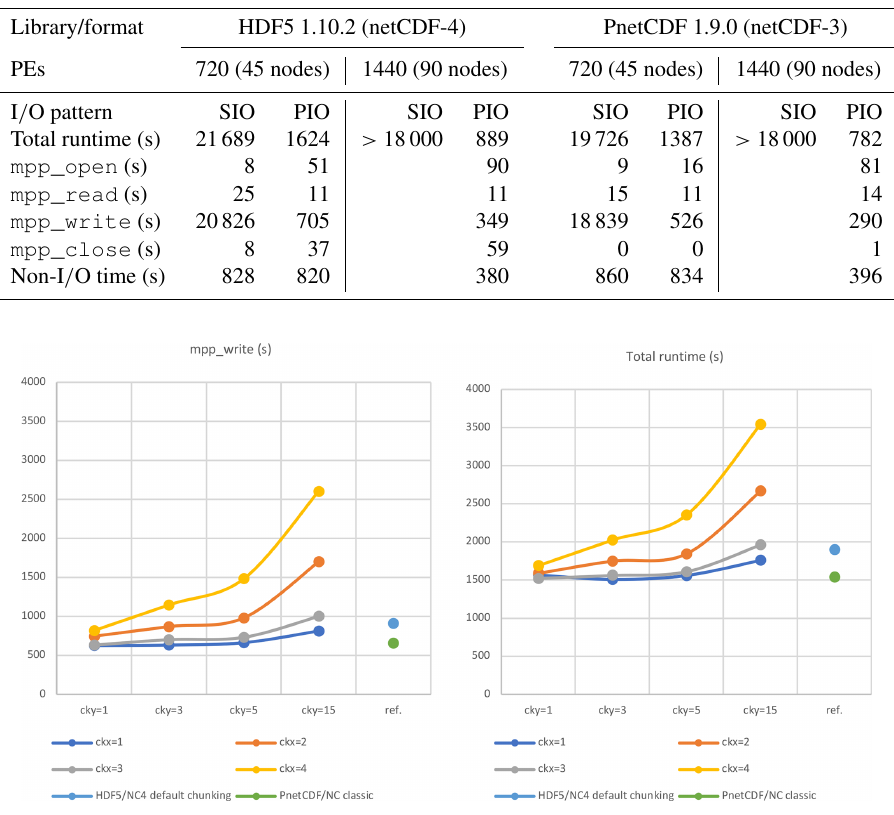
Figure 15. Performance of 720 PE runs with customized chunk layouts in HDF5/netCDF-4. The default chunk layout of HDF5/netCDF-4 and contiguous layout of PnetCDF/netCDF-3 are shown as